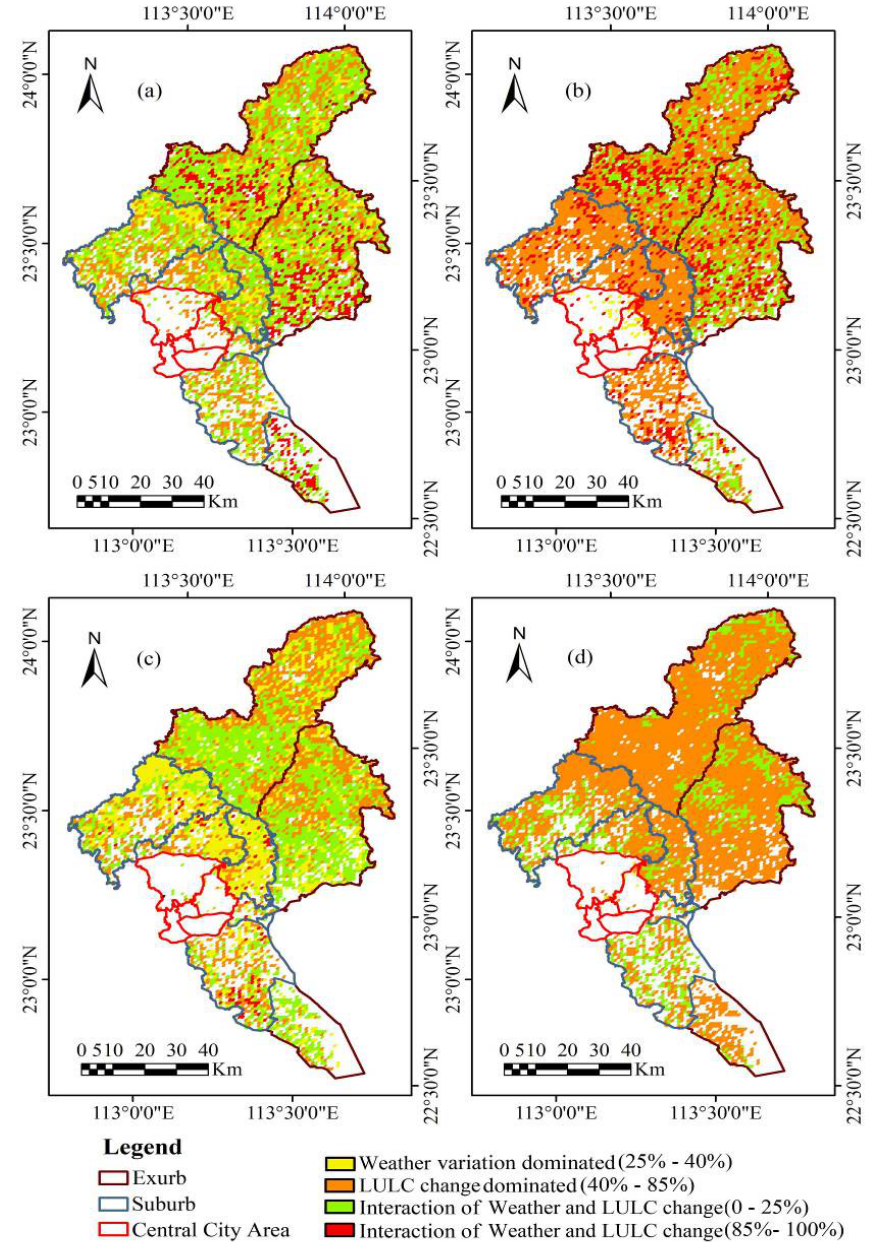
Figure 6. Spatial mapping of three effects patterns in the central area, suburb and